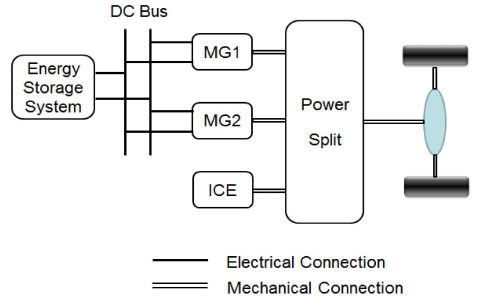
Figure 7. The basic configuration of the